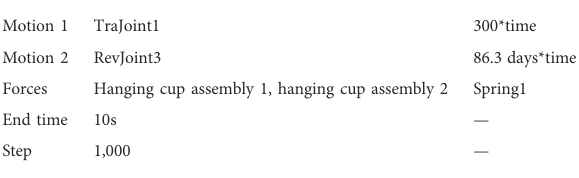
TABLE 4 Other simulation conditions (planting frequency: 72 plants/